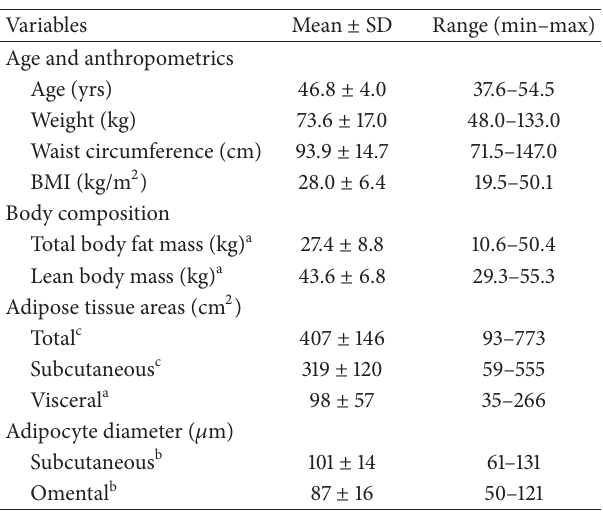
Table 1: Characteristics of the sample ( 𝑛 = 46).